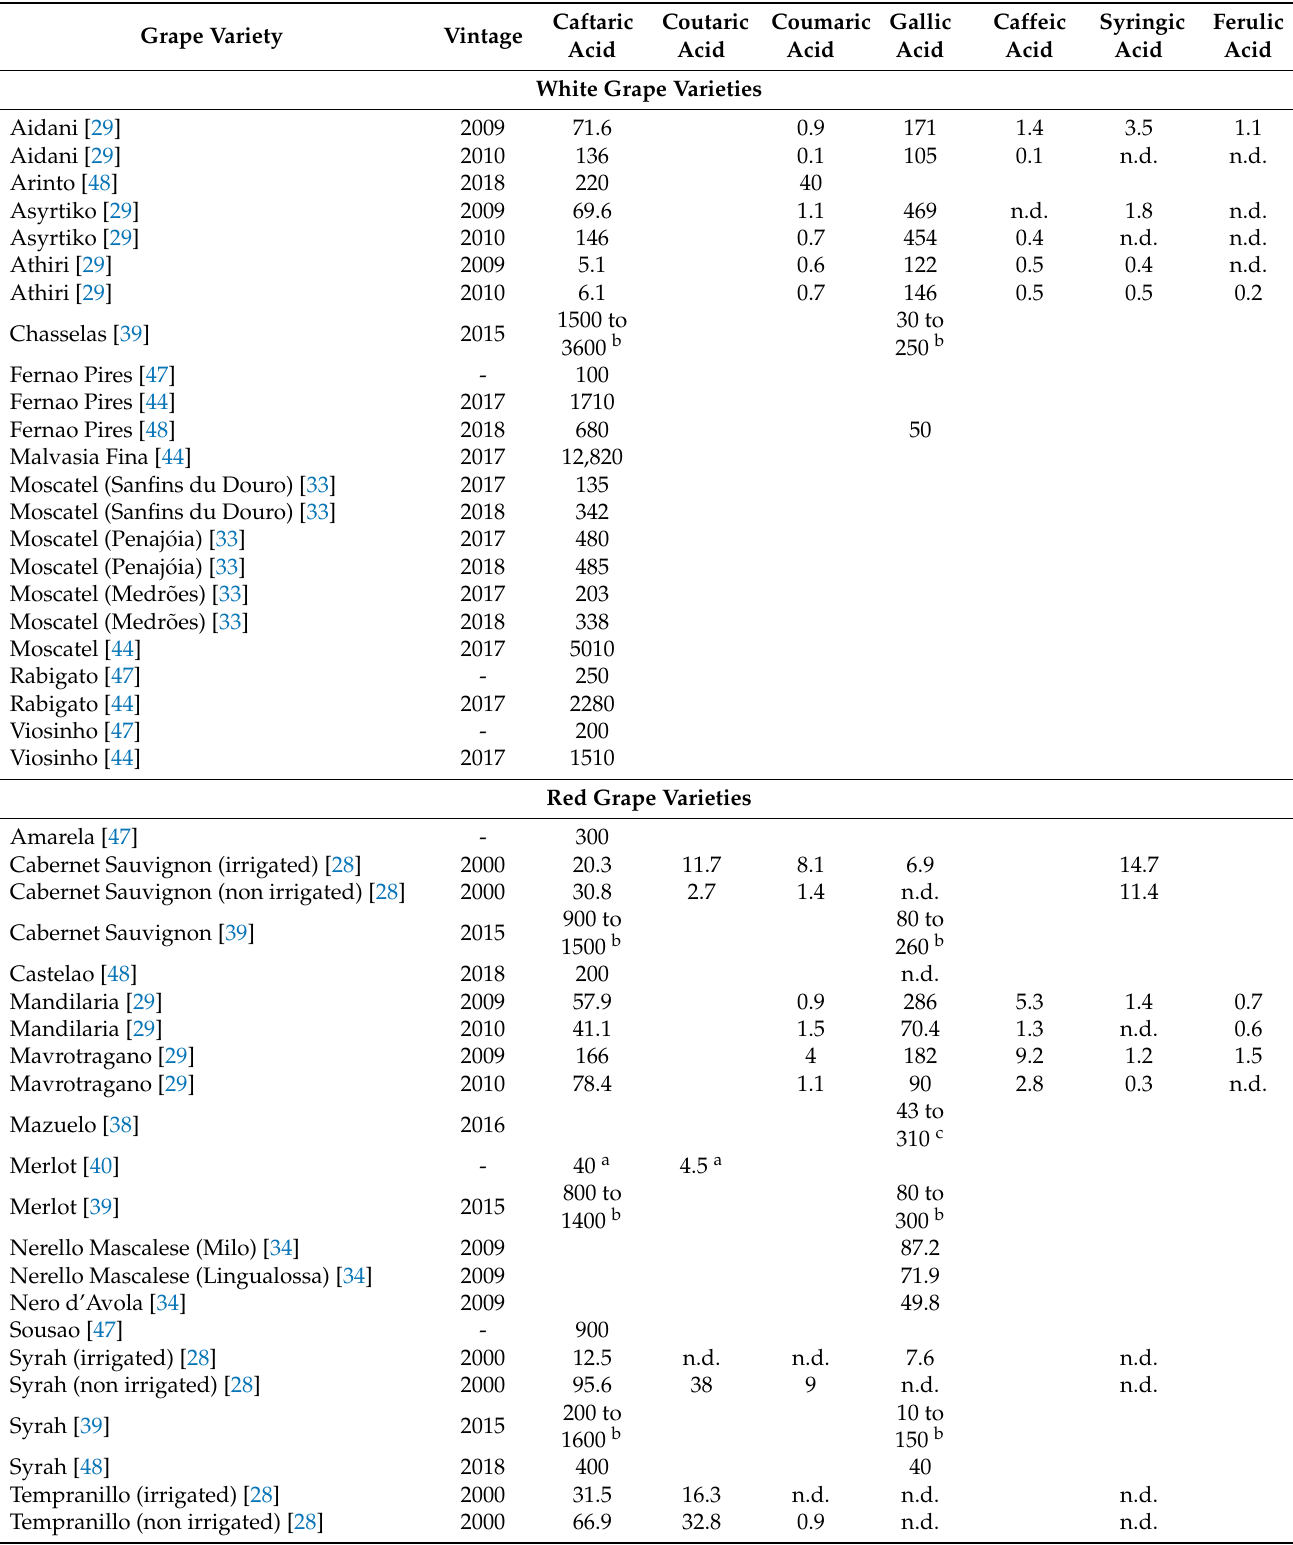
Table 3. Quantification of phenolic acids in white and red grape varieties (mg/kg DM). Grape